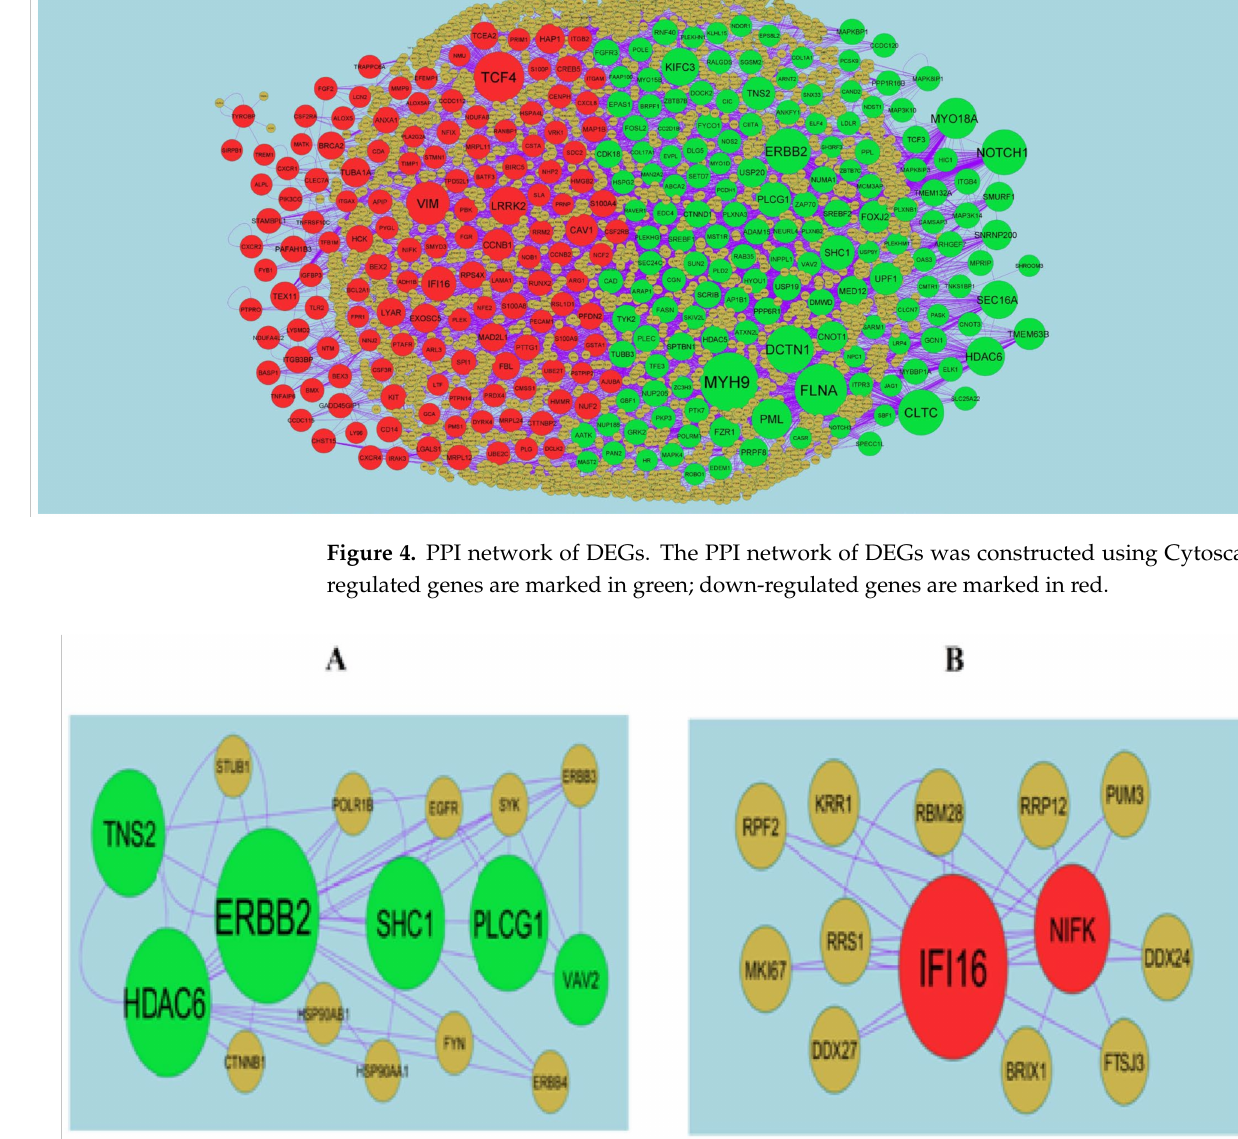
Figure 5. Modules of isolated form PPI of DEGs. ( A ) The most significant module was obtained from PPI network with 16 nodes and 39 edges for up-regulated genes. ( B ) The most significant module was obtained from PPI network with 13 nodes and 24 edges for down-regulated genes. Up-regulated genes are marked in green; down-regulated genes are marked in